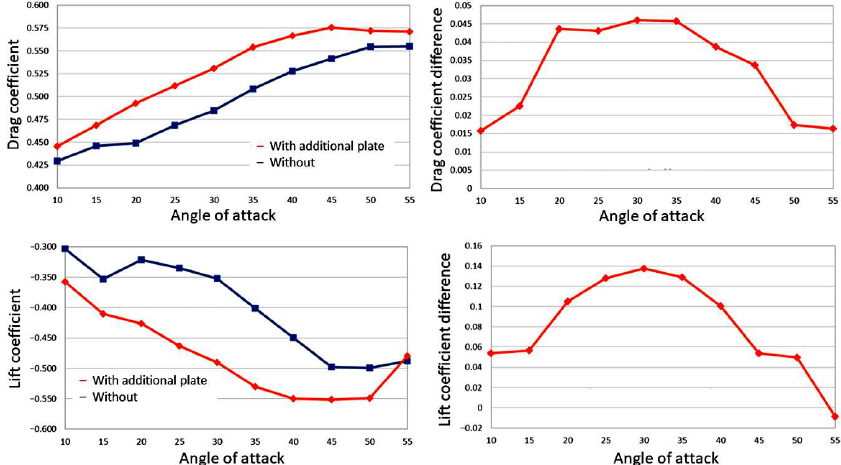
Figure 12. Aerodynamic characteristics Cx and Cl of the car with the spoiler and with the additional booster plate as a function of the spoiler setting